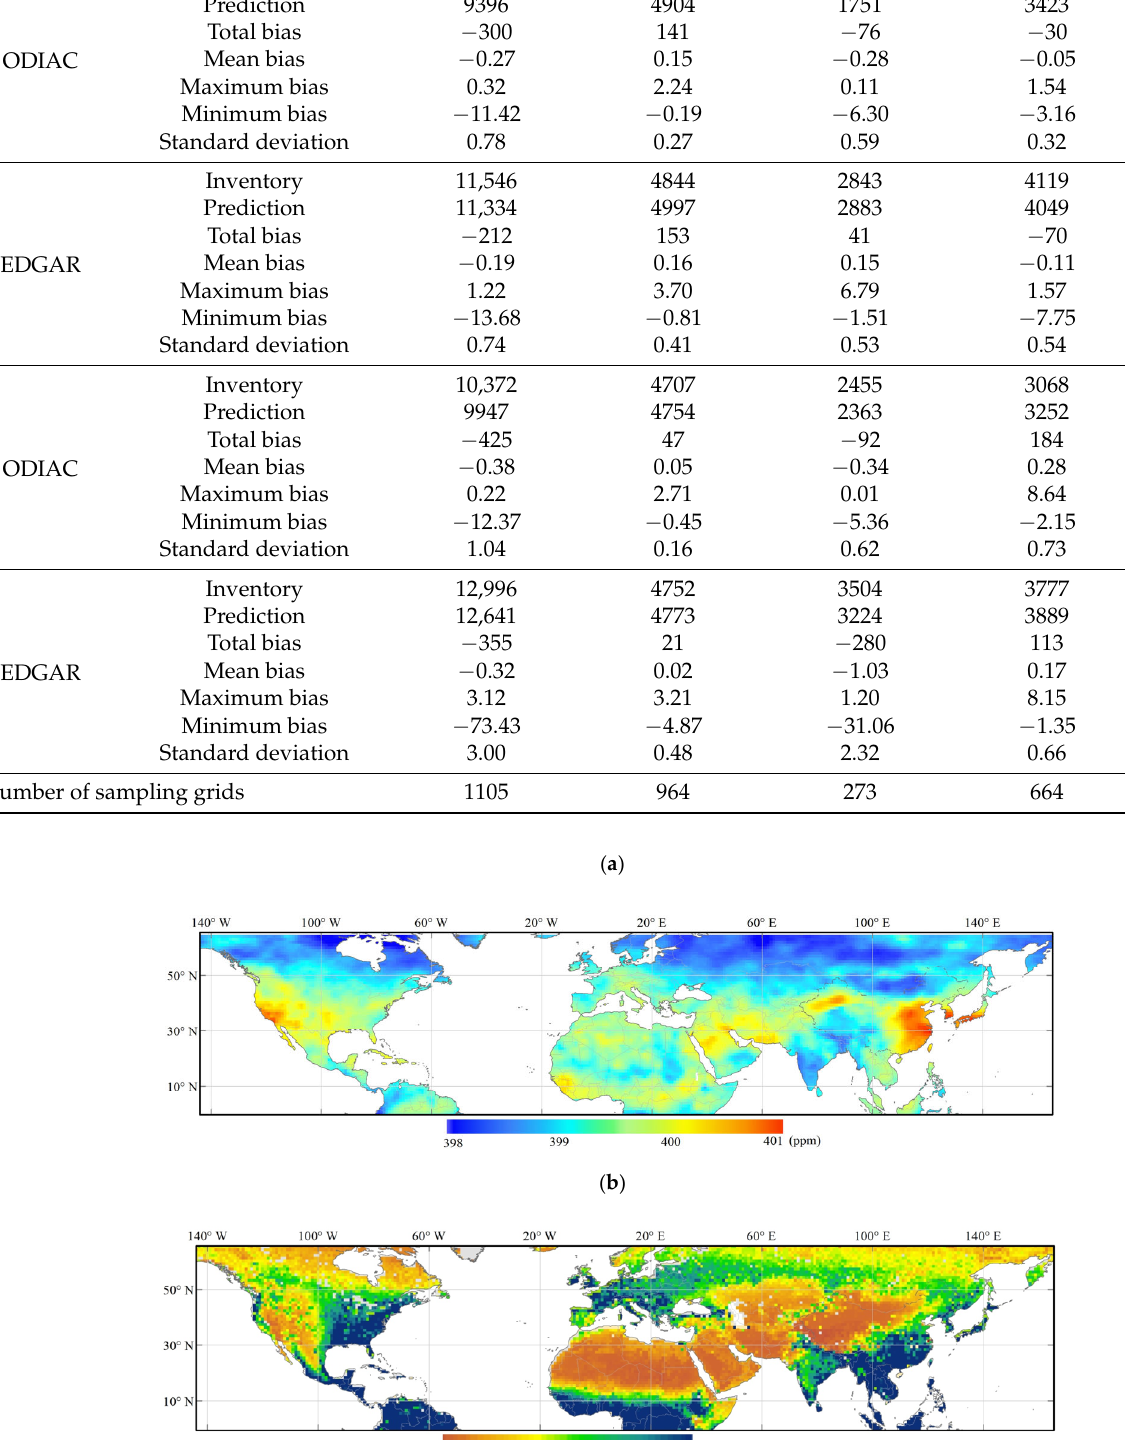
( a ) ( b ) Figure A3. Temporal variations of ( a ) averaged emissions of ODIAC, EDGAR, and ( b ) XCO 2 and SIF in the Northern Hemisphere.